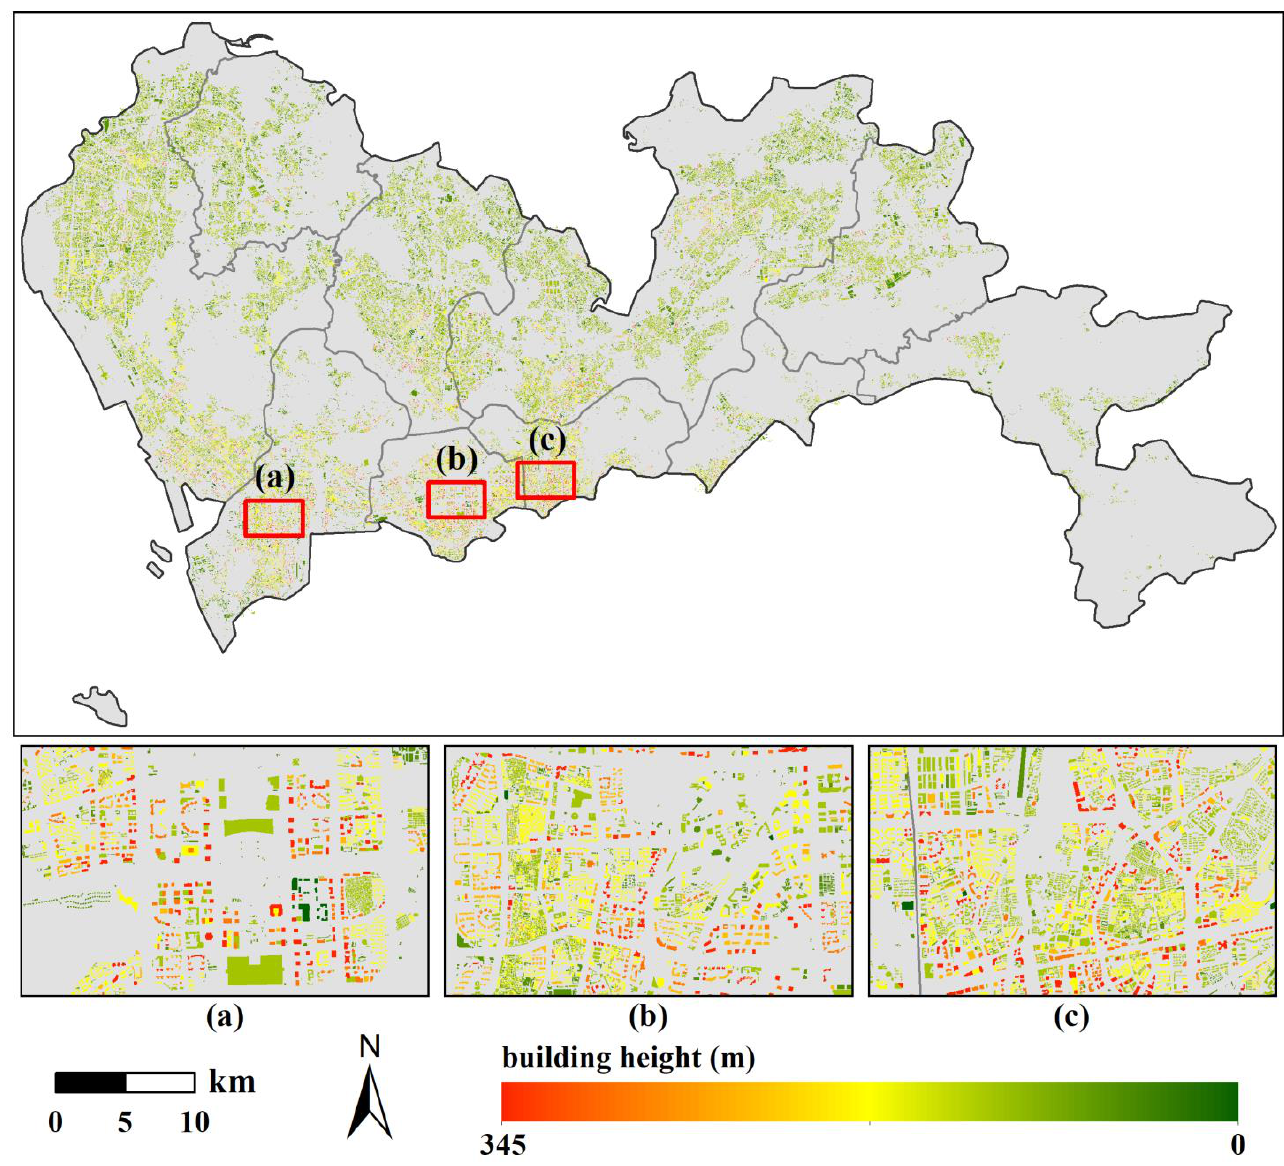
Figure 3. Spatial distribution of building heights in Shenzhen. (a) The central region of Nanshan District; (b) The central region of Futian District; (c) The southwestern region of Luohu District.